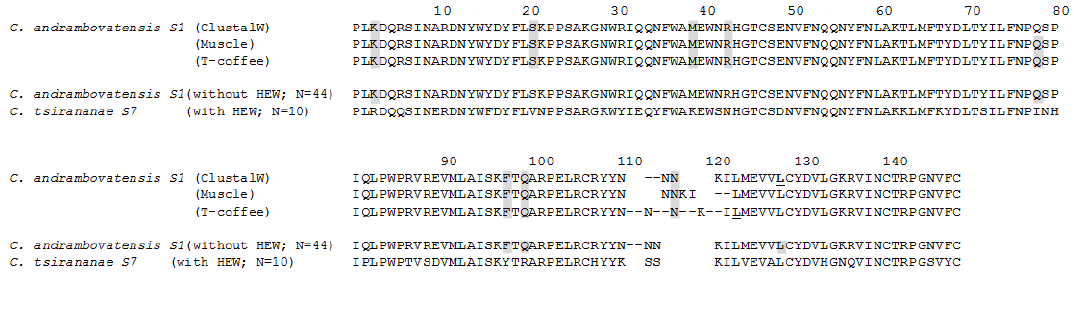
Figure 6: Positively selected amino acid sites. Gray - NEB (Naive Empirical Bayes) and BEB (Bayes Empirical Bayes) > 95%; Underscore - 90% < NEB and BEB < 95%. White spaces were introduced in the alignment in order to have a better view of the orthologous positions, under the different multiple alignments produced by different algorithms. Bold - positively selected amino acids identified with model M8 but not with model M2. For T-Coffee, results are only shown for model M2, since there was no convergence when using model